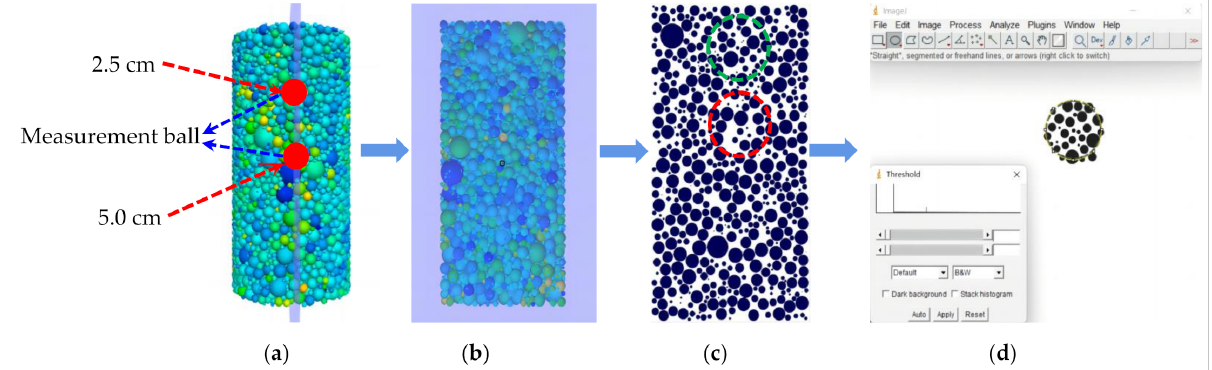
Figure 8. Eolian sand slicing process; ( a ) Overall sample and measurement ball of position; ( b ) Sample section; ( c ) Selected position; ( d ) ImageJ